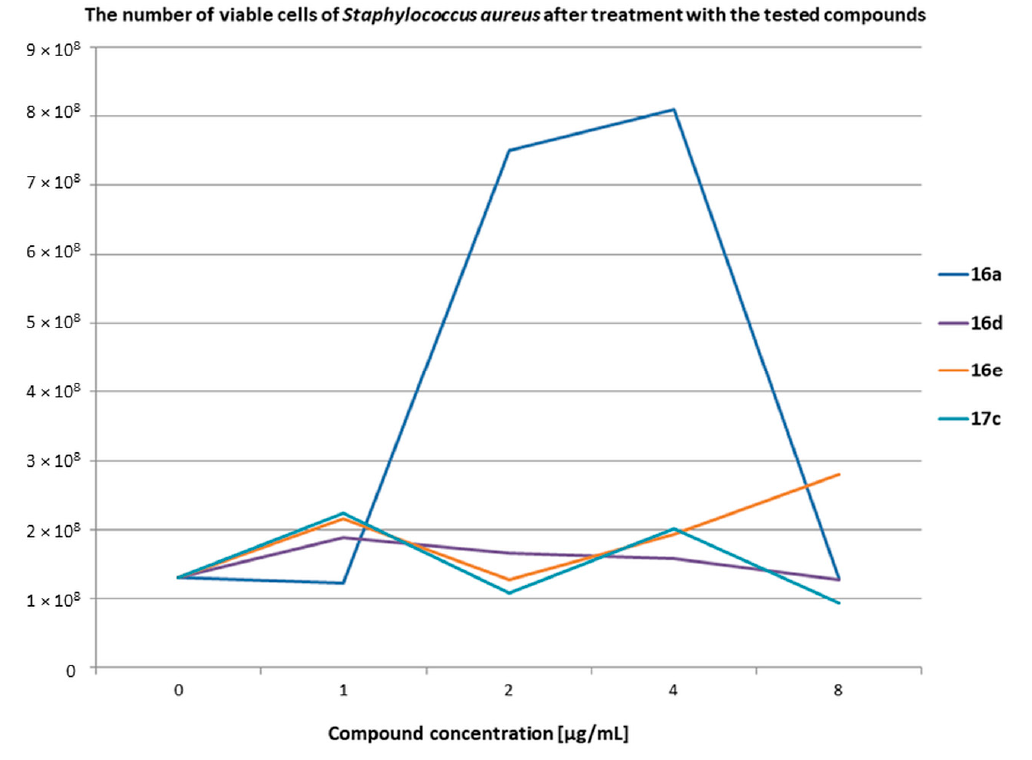
Figure 8. The results of the measurement of the number of viable cells of S. aureus after treatment with the tested compounds at various concentrations. t 0 1.30 × 10 8 ; t 24 2.28 × 10 9 . Table 3. The results of the measurement of the number of viable cells of Staphylococcus epidermidis after the action of the tested compounds at various concentrations.